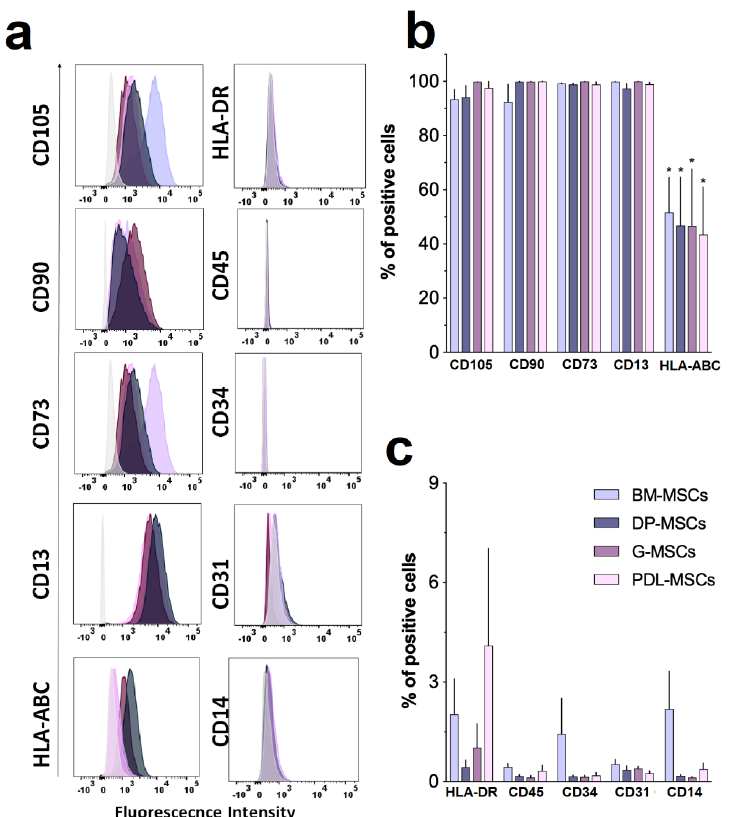
Figure 1. The expression of cell markers in dental tissue–mesenchymal stem cells (DT-MSCs) was determined by flow cytometry. ( a ) Representative histograms for one experiment (gray histogram: isotype control, ( b ) DT-MSC cultures show a high expression of surface markers characteristic of MSCs (CD105, CD73, CD90, and CD13), moderate expression of human leukocyte antigen (HLA)-ABC, and ( c ) negative expression for hematopoietic markers (CD45, CD34, and CD14), endothelial markers (CD31) and HLA-DR; bone marrow (BM)-MSCs (n = 5), dental pulp (DP)-MSCs (n = 5), gingival tissue (G)-MSCs (n = 5), and periodontal ligament (PDL)-MSCs (n = 5). The results represent the mean ± SD and correspond to the percentage (%) of cells positive for each particular antigen. *Significant di ff erence ( p < 0.05) compared with CD105, CD73, CD90, and